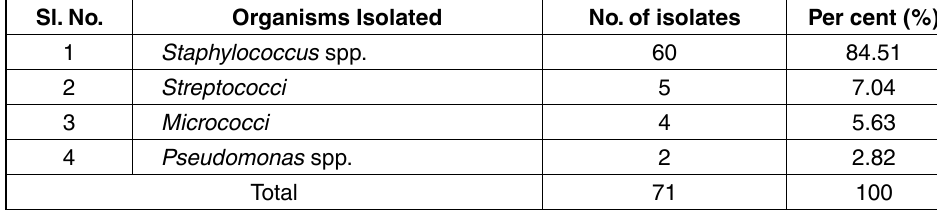
table 5 . Differentiation of bacterial isolates obtained sl. No. 1 Staphylococcus spp. 3 Micrococci 4 Pseudomonas